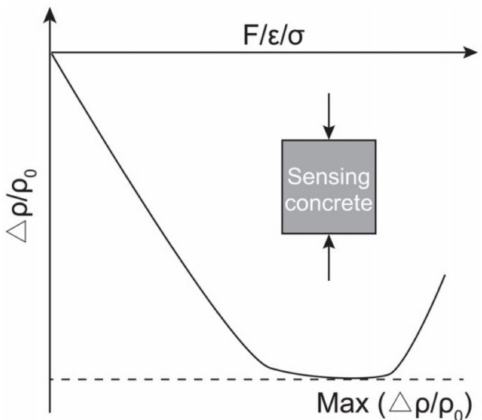
Figure 5. Self-sensing concrete under monotonic. Reproduced with permission from [51], Journal of Applied Physics,